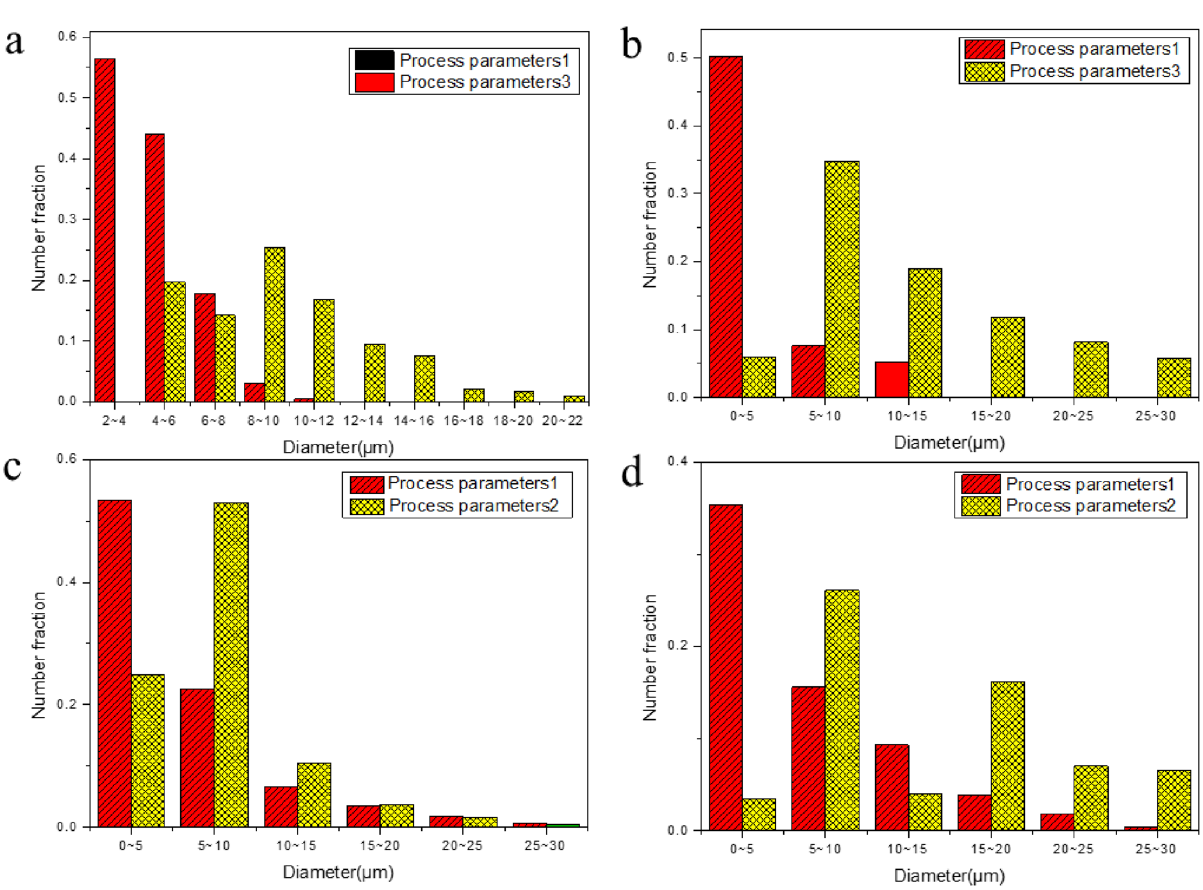
Figure 7. Grain Size of ( a ) Fe 2 Ti, ( b ) FeTi, ( c ) α-Fe, and ( d ) α-Ti